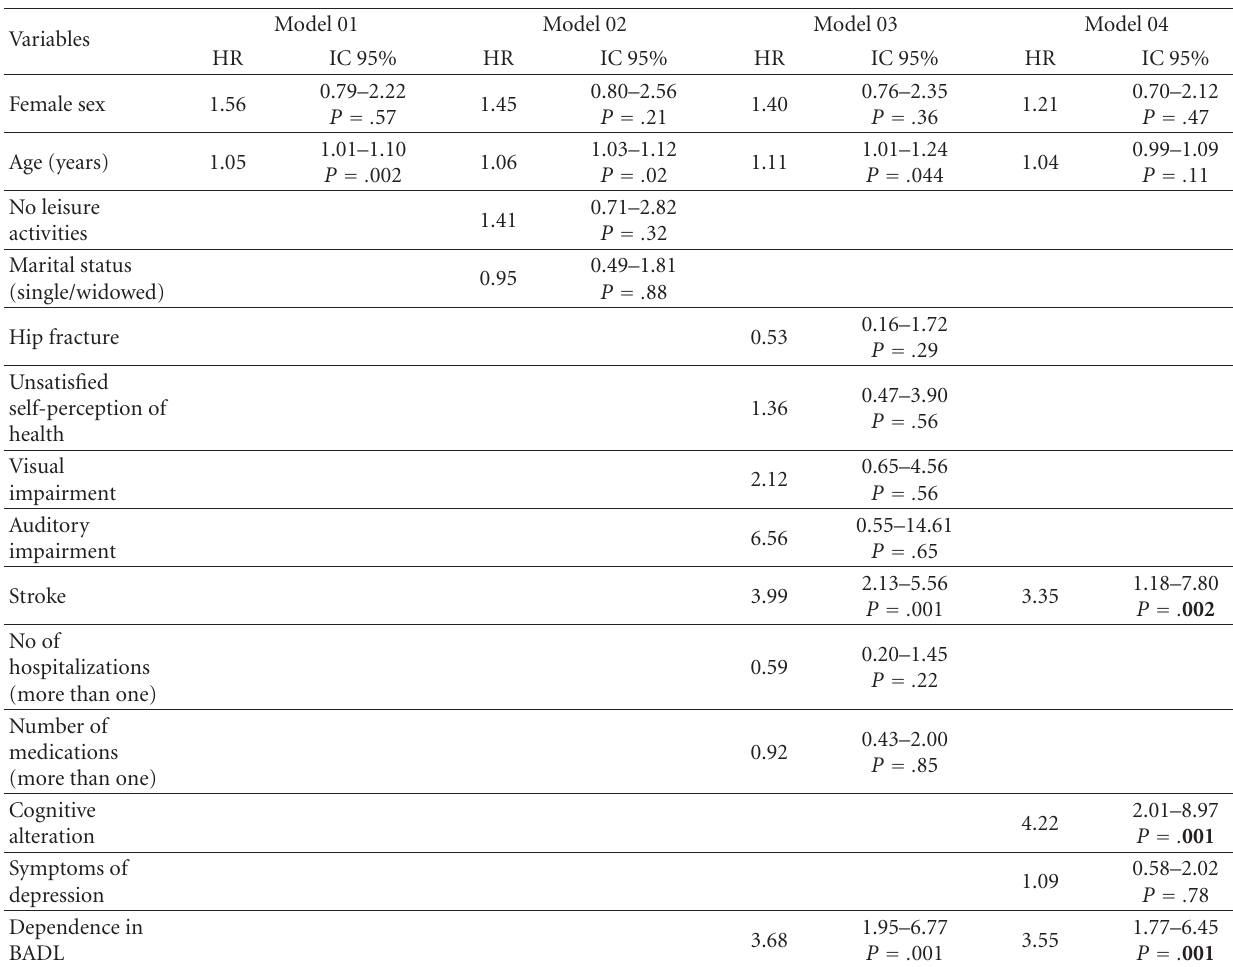
Table 4: Result of the Cox Regression, with the predicting variables of mortality of elderly from Santa Cruz, Rio Grande do Norte,